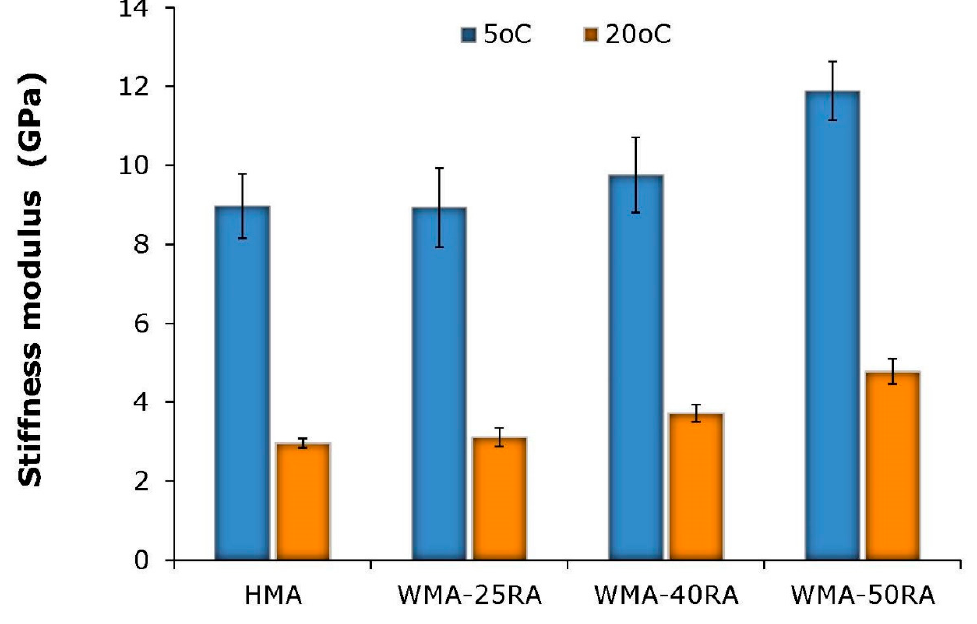
Figure 6. ITSM Figure 6. ITSM results. Figure 6. ITSM results.